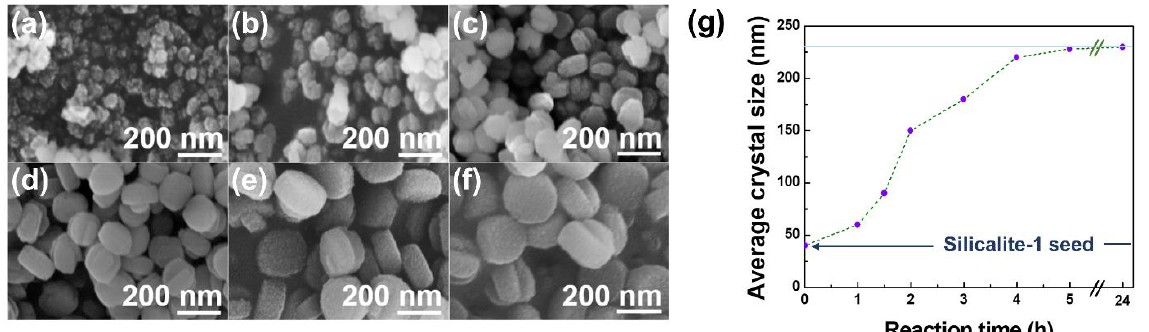
Figure 3. Crystal size change of Al-ZSM-5 based on reaction time. SEM imagery of seeded grown Al-ZSM-5 after crystallization at 120 °C for ( a ) 1 h; ( b ) 1.5 h; ( c ) 2 h; ( d ) 3 h; ( e ) 4 h; and ( f ) 5 h. Zeolite growth was conducted using the synthesis sols of 4050 H 2 O:4.5 TPAOH:20 SiO 2 :x Al 2 O 3 :2x NaOH (x = 0.07). The amount of the silicalite-1 seeds relative to TEOS, was 3.62 × 10 −2 wt%. ( g ) Changes in crystal size according to reaction time. The average particle size of silicalite-1 seeds and maximum crystal size are marked in the dark blue line and bright blue line, respectively.